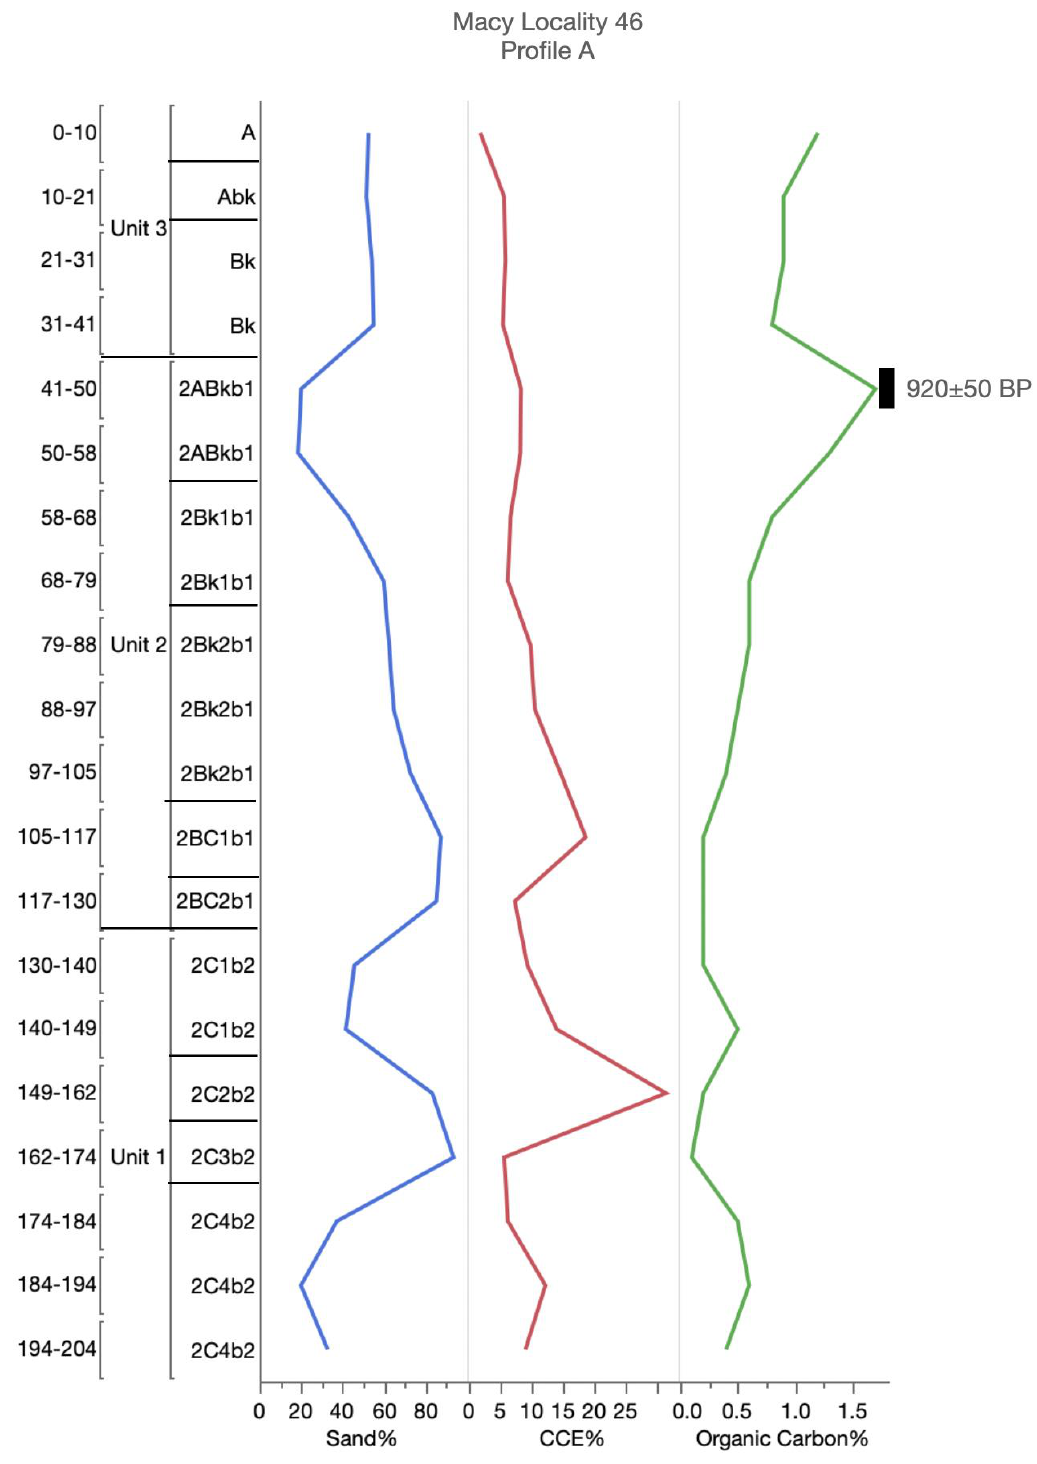
Figure A6. Accepted radiocarbon ages and soil and sediment analysis at Macy Locality 46, Profile A — Post research area, northwest, Texas. CCE = calcium carbonate equivalence.